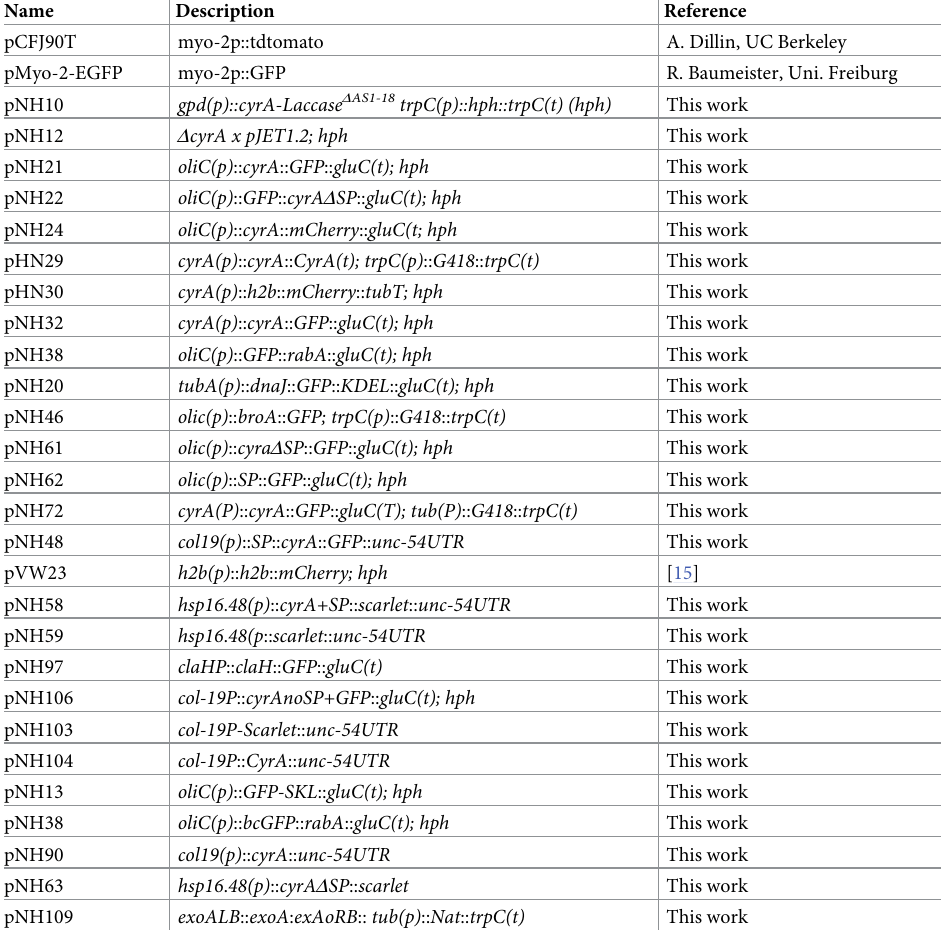
Table 4. Plasmids used in this